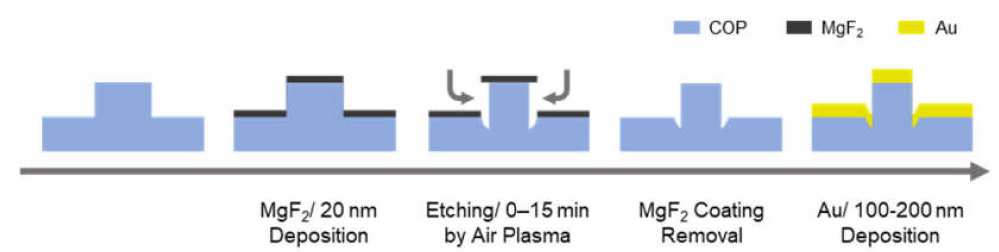
Figure 1. Re-shaping process of the secondary polymer mold. We thermally deposited a 20 nm MgF 2 mask on the COP nanopillar mold and etched the nanopillar by means of air plasma gas from the side wall. After etching, we removed the MgF 2 mask by dipping it in 30% nitric acid, and the re-shaped COP mold was obtained. Finally, to form the plasmonic device, we thermally deposited Au on the COP